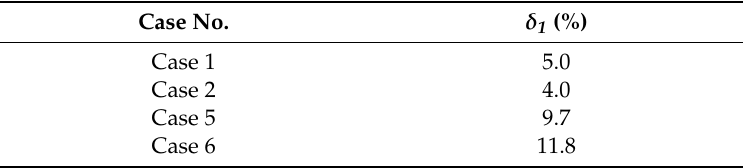
Table 3. Error analysis for the modified